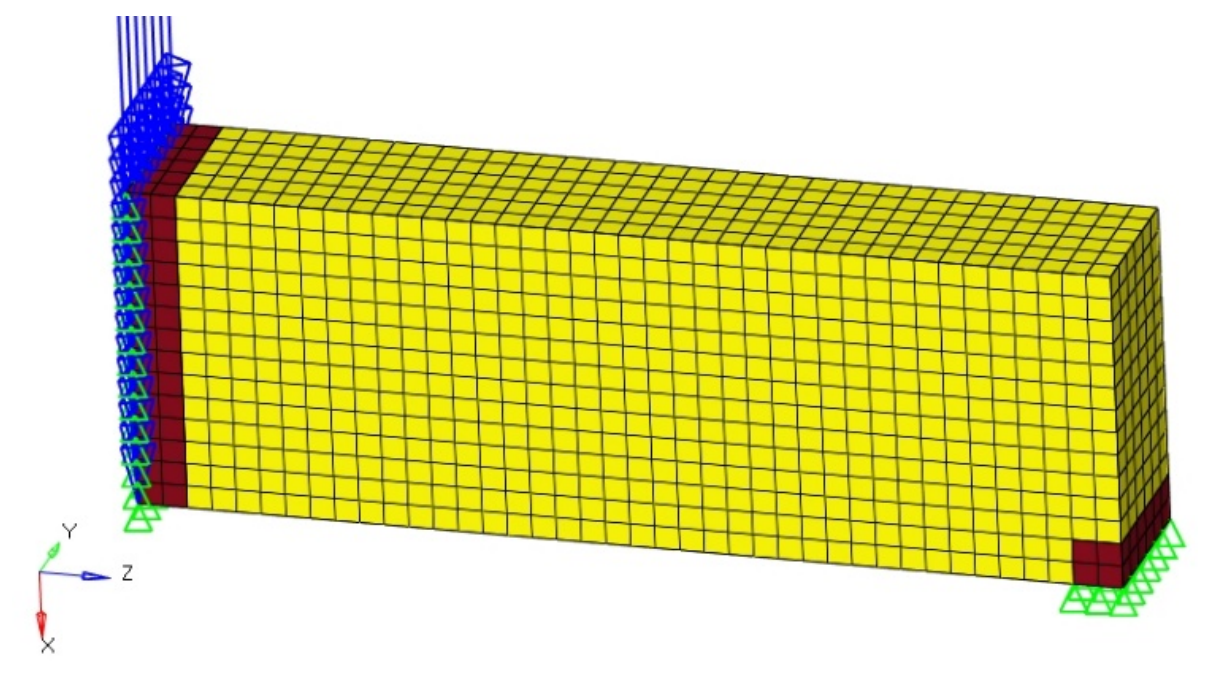
Figure 14. MBB Initial Problem, Yellow = Design Space, Brown = Non-design Space.